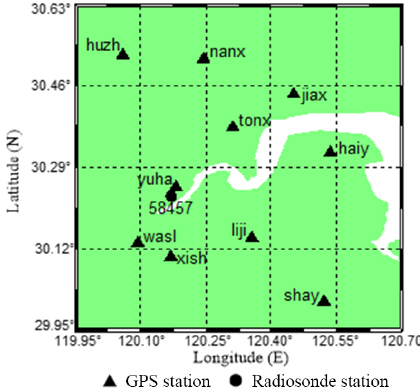
Figure 4. Distribution of receiver stations and radiosonde